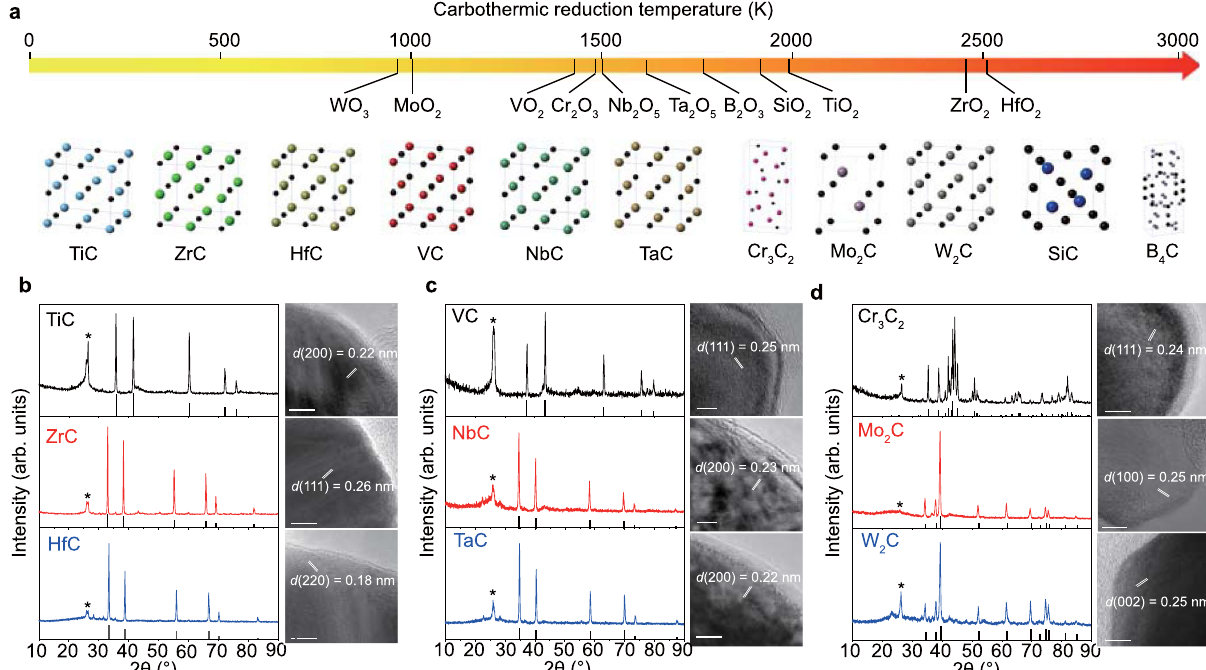
Fig. 5 Generalized strategy for carbide synthesis. a Carbothermic reduction temperature of oxides derived from the Ellingham diagram, and the crystal structures of eleven carbides. b X-ray diffraction (XRD) patterns and high-resolution transmission electron microscopy (HRTEM) images of group IVB metal carbides. The PDF reference cards for each are TiC, 65 – 7994; ZrC, 65 – 8834; and HfC, 65 – 7326. c XRD patterns and HRTEM images of group VB metal carbides. The PDF reference cards for each are VC, 65 – 8825; NbC, 65 – 8780; and TaC, 65-0282. d XRD patterns and HRTEM images of group VIB metal carbides. The PDF reference cards for each are Cr 3 C 2 , 65 – 0897; Mo 2 C, 35 – 0787; and W 2 C, 20 – 1315. Scale bars are 5 nm in b , c , and d . The peak at ~26° (star) for all the samples is attributed to graphene